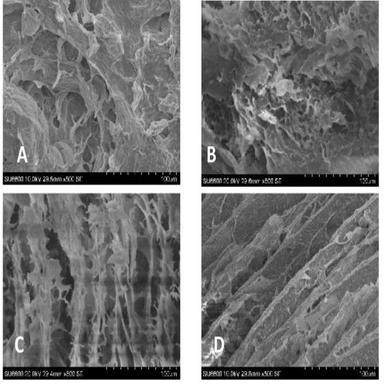
SEM micrographs – PR52.